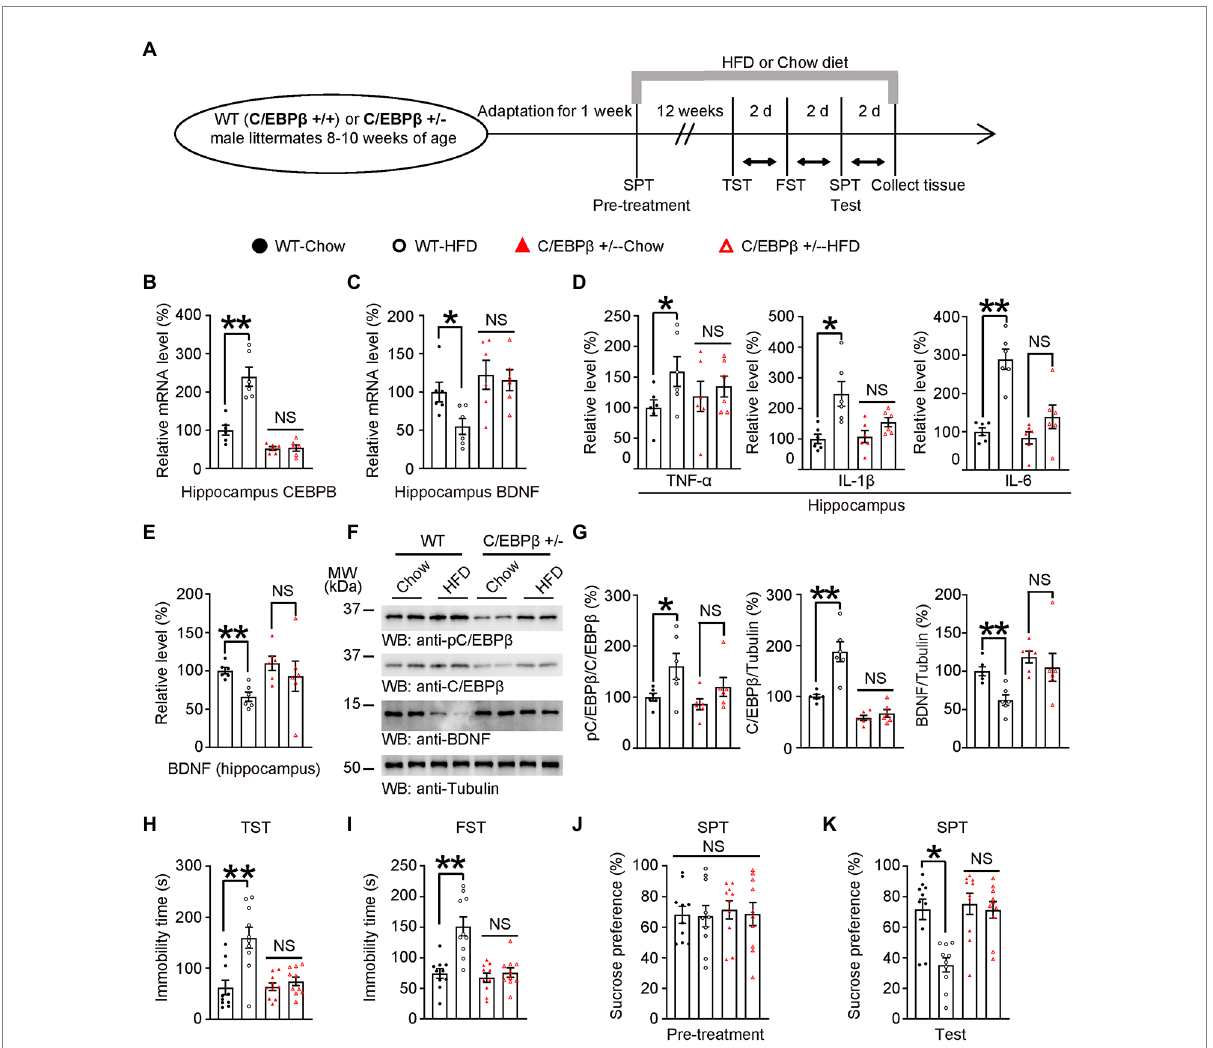
FIGURE 3 Knocking of C/EBP β alleviates HFD-induced depression-like behaviors. (A) Schematic of the HFD or chow diet course and behavioral tests process. HFD, high-fat diet; TST, tail suspension test; FST, forced swim test; SPT, sucrose preference test; d, day. (B) Hippocampal CEBPB mRNA levels in 8–10 week-old wild-type (C/EBP β +/+) and C/EBP β +/ − male mice fed with HFD or chow diet for 12 weeks. Data represent the mean ± SEM of six samples per group (** p < 0.01; NS, not significant; one-way ANOVA and Bonferroni’s multiple comparison test). (C) Hippocampal BDNF mRNA levels. Data represent the mean ± SEM of six samples per group (* p < 0.05; NS, not significant; one-way ANOVA and Bonferroni’s multiple comparison test). (D,E) ELISA quantification of (D) TNF α , IL-1 β , and IL-6 and (E) BDNF in the brain lysates from the above mice. Data in (D,E) represent the mean ± SEM of six samples per group (* p < 0.05, ** p < 0.01; NS, not significant; one-way ANOVA and Bonferroni’s multiple comparison test). (F) Representative immunoblots and (G) quantification of hippocampal p-C/EBP β , C/EBP β , and BDNF protein expression. Data in (F) are representative of three independent experiments. Data in (G) represent the mean ± SEM ( n = 6 for each group, * p < 0.05, ** p < 0.01; NS, not significant; one-way ANOVA and Bonferroni’s multiple comparison test). (H) Tail suspension test, (I) forced swim test and (J,K) sucrose preference test for the above mice. Data represent the mean ± SEM ( n = 10 mice for each group; * p < 0.05; NS, not significant; one-way ANOVA and Bonferroni’s multiple comparison